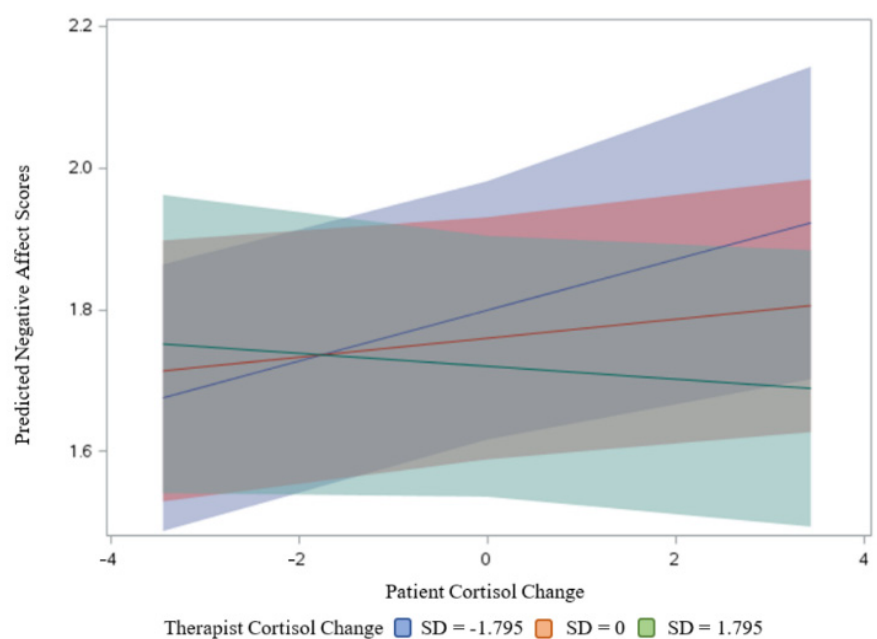
Figure 2. Interaction of patient and therapist cortisol change predicting negative affect. Note. The relationship between patients’ cortisol change and NA was positive and significant when their therapists showed smaller increases (or greater decreases) in cortisol (represented in blue), but this association was diminished when their therapists showed greater increases in cortisol (represented in green).